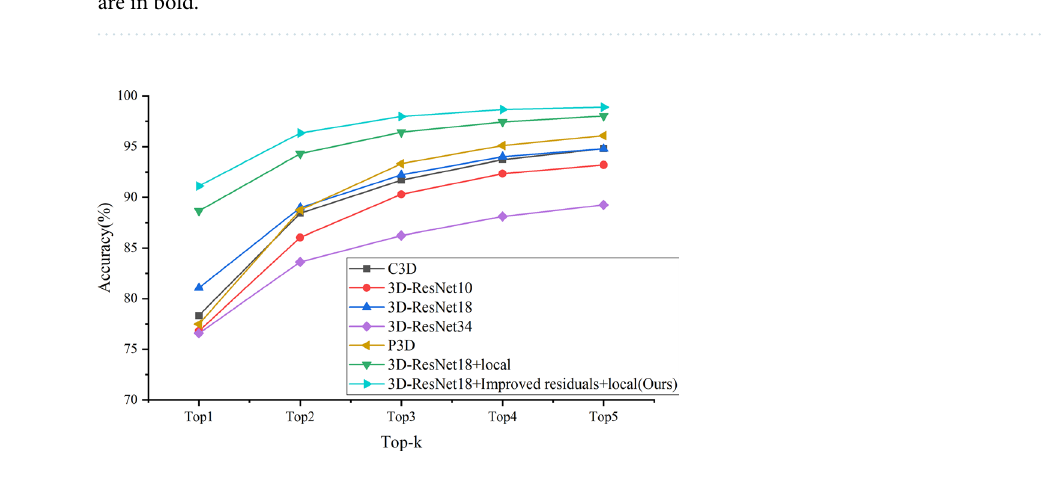
Figure 18. Comparison of recognition accuracy of different